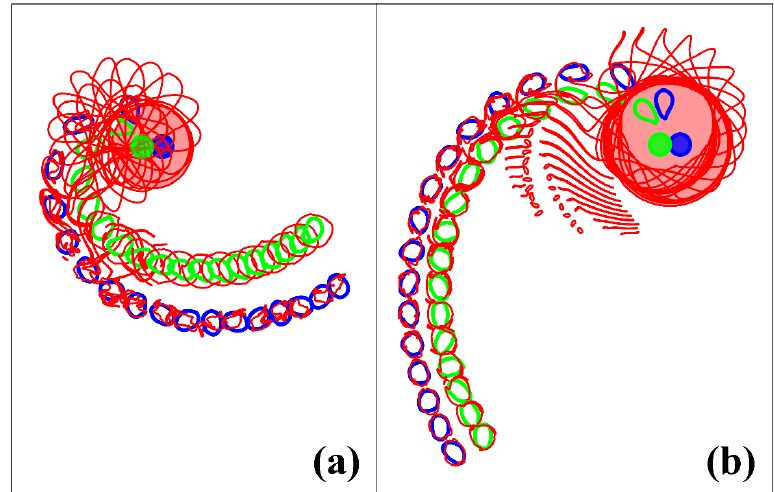
Figure 9. Interaction of a surface cyclonic vortex with P 1 = 0.6 and the pair of vortex patches located in the middle layer with 𝑟 21 = 𝑟 22 = 1 , 𝛲 21 = −𝛲 22 = −0.01875 at 𝐿 = 1. The contour of the cyclonic/anticyclonic vortex in the middle layer is in green/blue: ( a ) 𝑟 1 = 4 , ( b ) 𝑟 1 = 6.